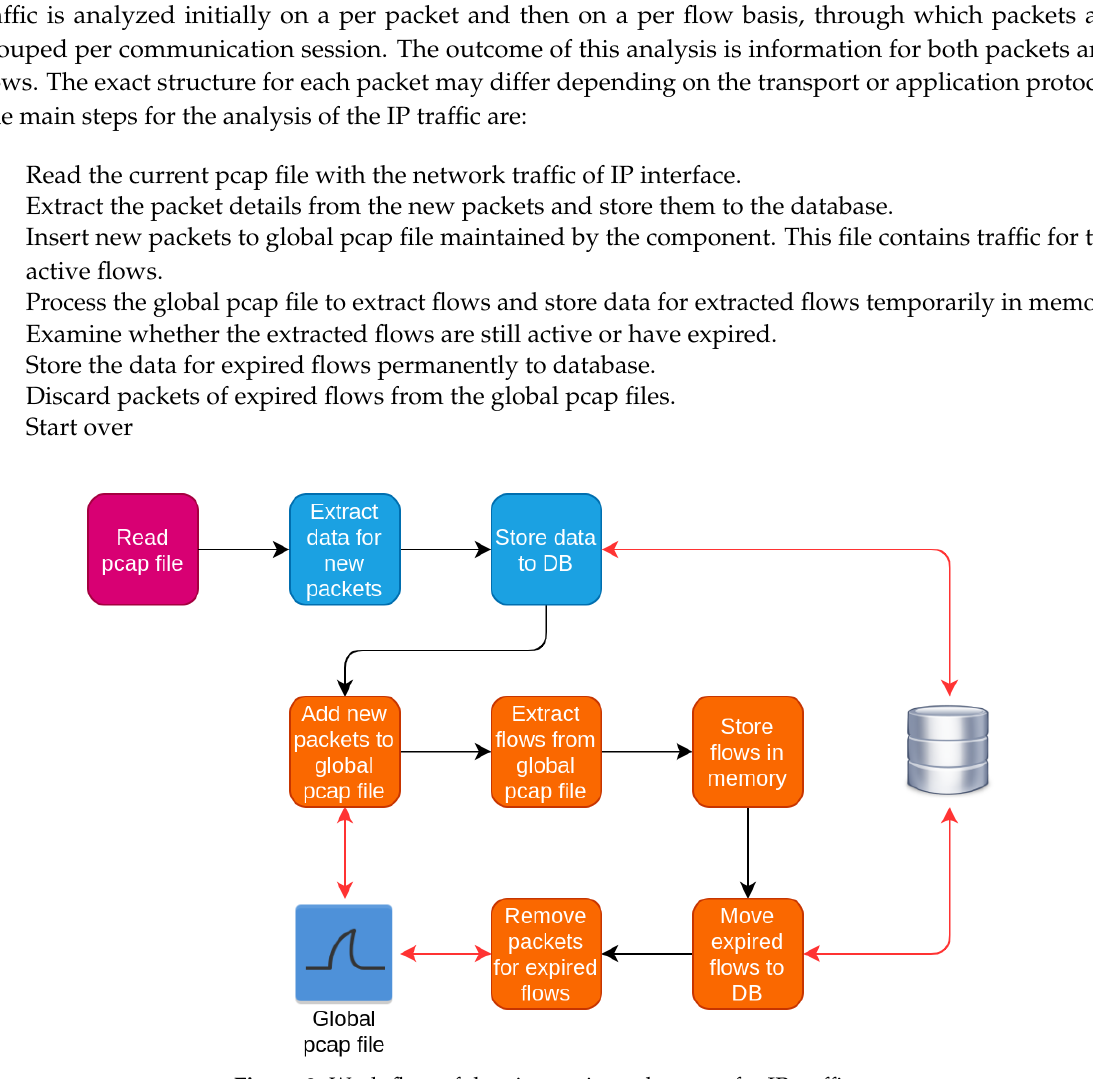
Figure 3. Work-flow of data inspection subsystem for IP